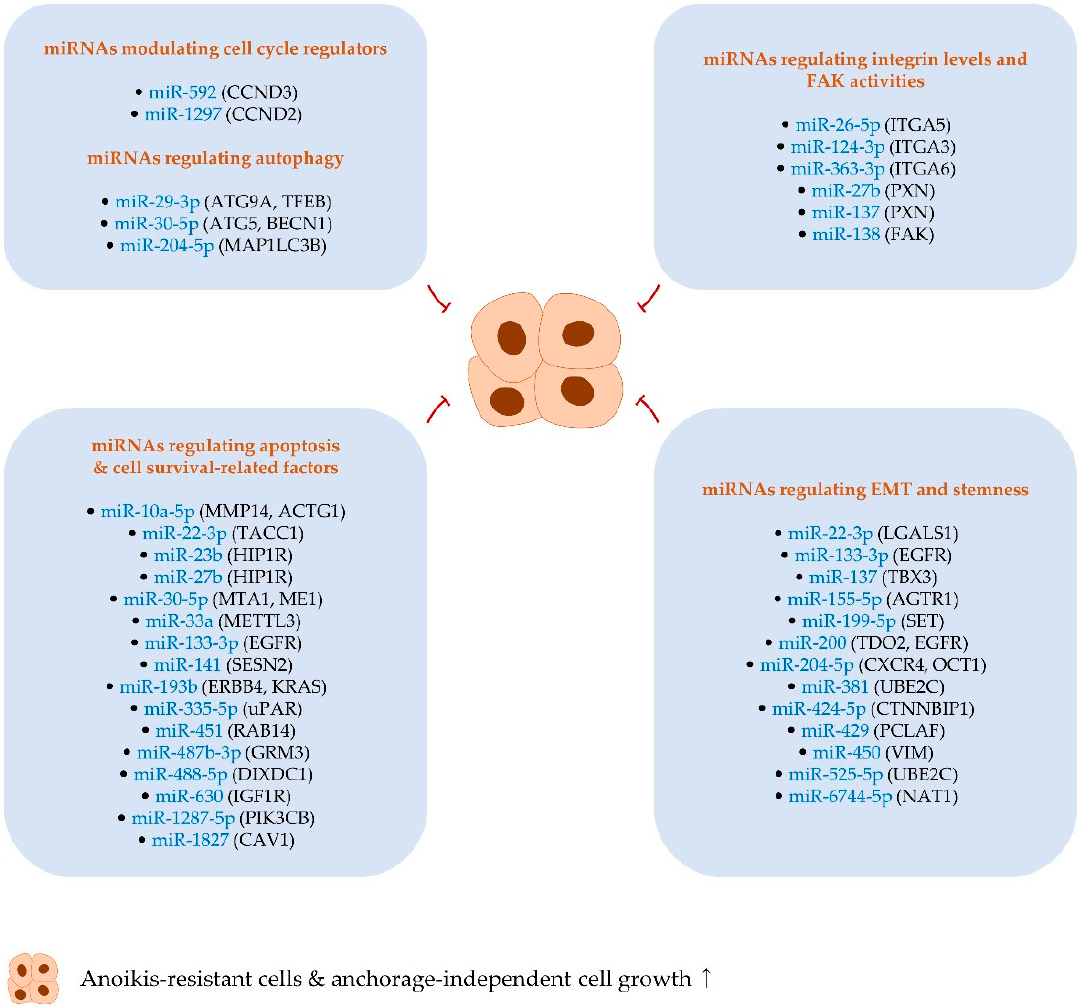
Figure 2. Tumor-suppressive miRNAs (blue) and their relevant target genes (black) suppressing anoikis resistance and anchorage-independent cell growth in cancer. It is described in Table 2 and Section